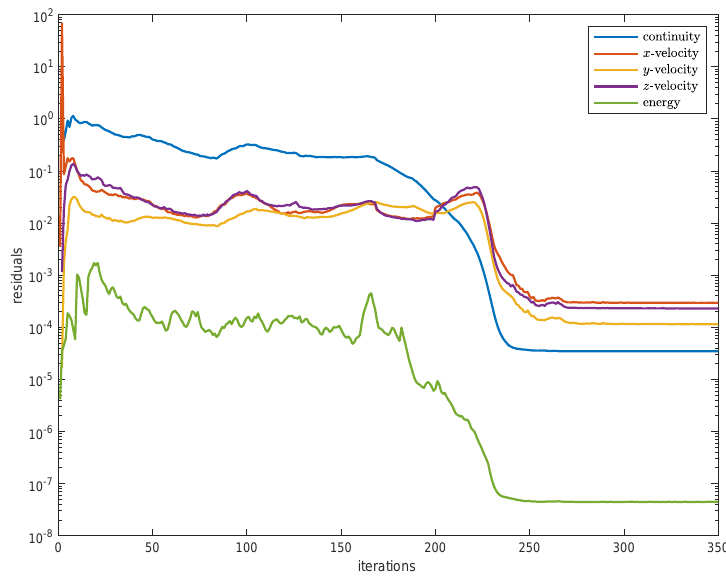
Figure 3. Scaled residuals of continuity, momentum, and energy equations when ˙ v = 30 L/h for an average day of July in Catania (Southern Italy), with orientation SOUTH and tilt 33 ◦